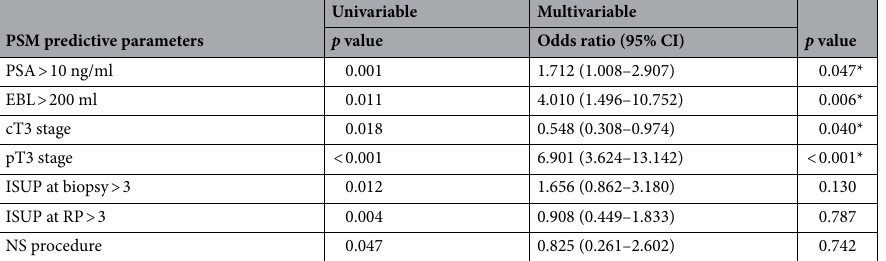
Table 4. Analysis of the primary parameters to predict positive surgical margins (PSM) after robotic prostatectomy by univariable analysis, and multivariable logistic regression analysis. PSA prostate-specific antigen, EBL estimated blood loss, cT clinical T stage by MRI, pT pathological stage by RP specimens, ISUP International Society of Urological Pathology, RP radical prostatectomy, NS nerve-sparing, * p value for difference between margins status in multivariable analysis < 0.05.